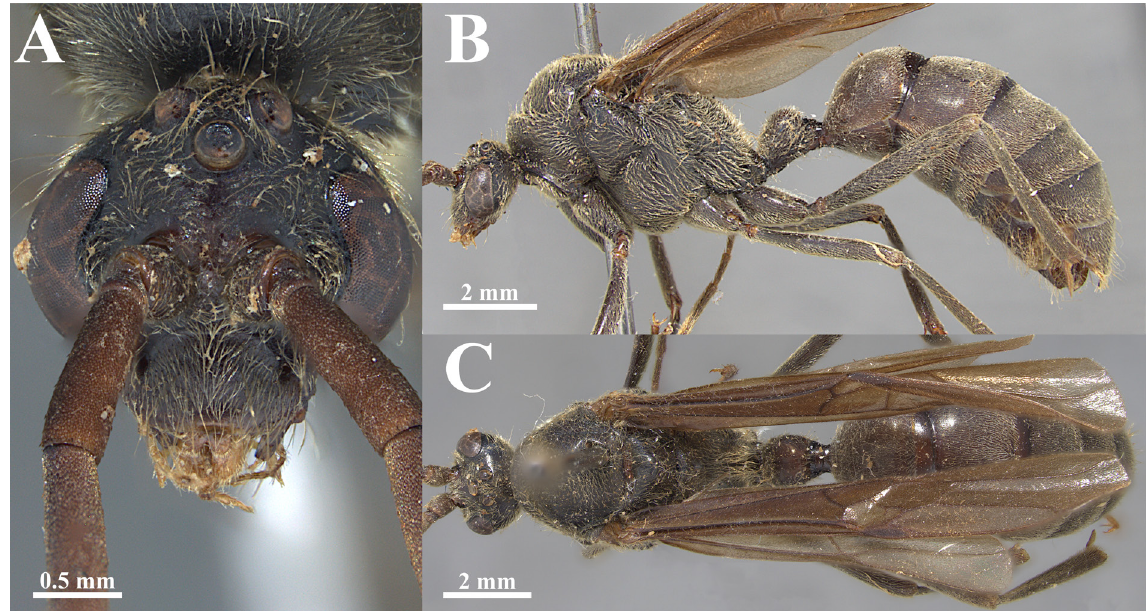
Fig. 16. Dinoponera grandis nigricolor Borgmeier, 1937 syn. nov., lectotype, ♂ (Campinas, Goiás, Brazil; MZSP 65801). A . Full-face view. B . Full body in lateral view. C . Full body in dorsal